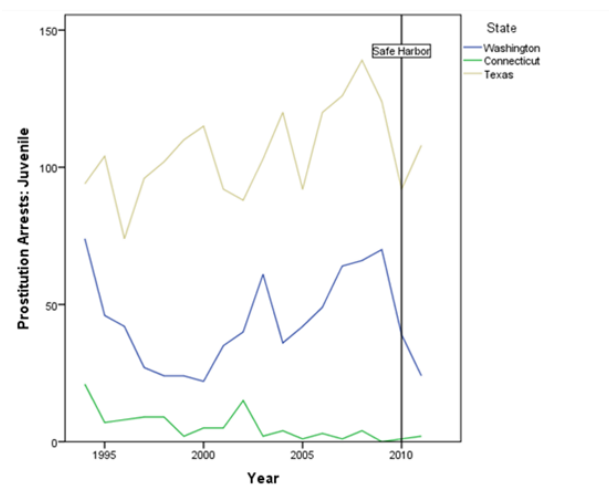
Figure 3. Juvenile prostitution arrests: Connecticut, Texas, and Washington.